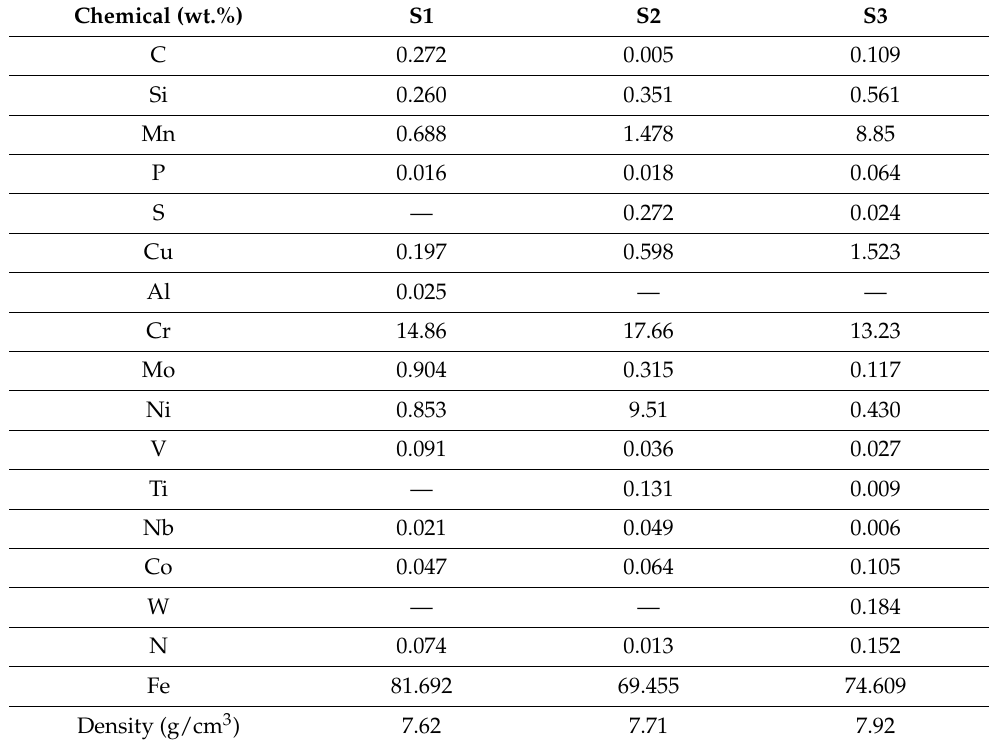
Table 1. The chemical composition and density for the investigated materials. Chemical